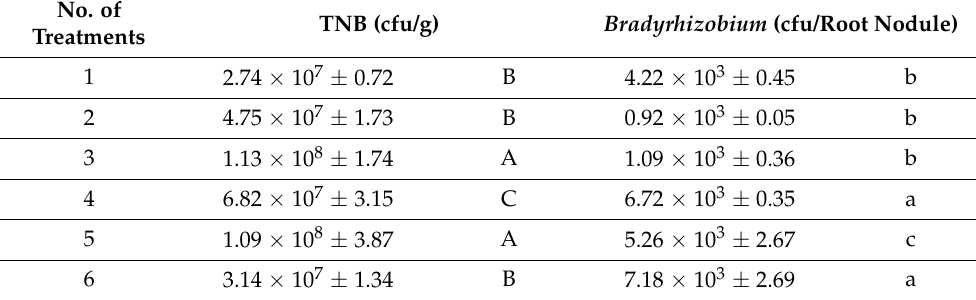
Table 4. Relationships between the tested treatments (applied in the dose of sewage sludge and fly ash), the TNB and the separate Bradyrhizobium .